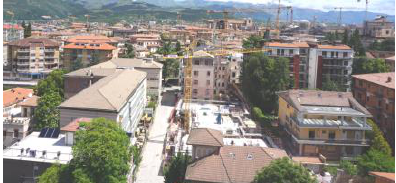
Figure 3. L’Aquila’s one oblique image showing the area